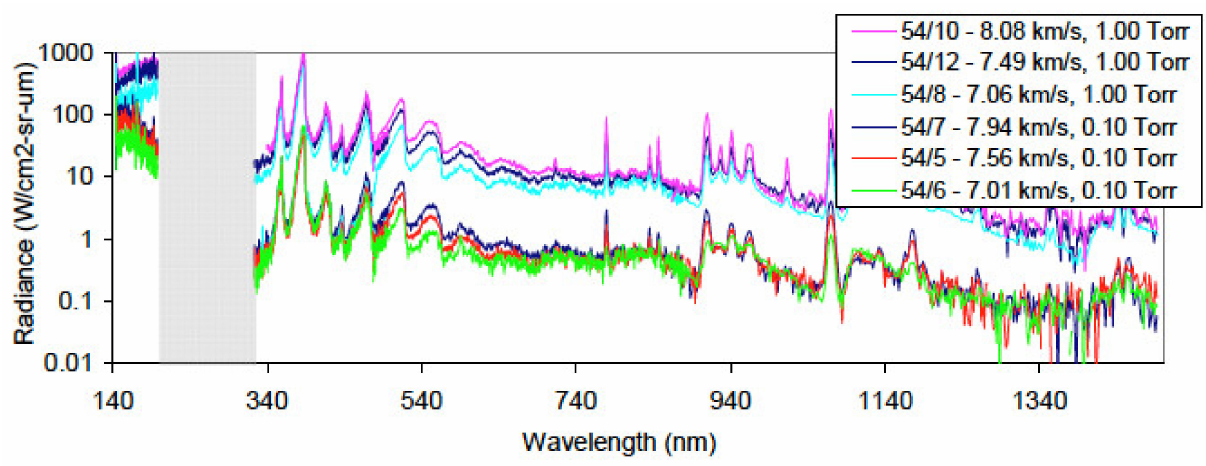
Figure 25. Composite spectra for TC 2 nominal conditions (from